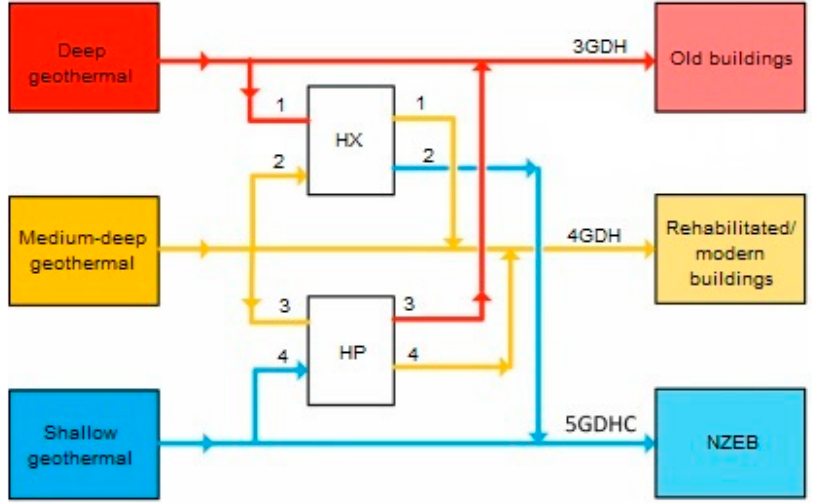
Figure 9. Scheme of the multi-depth geothermal system: 1-1—heat transfer from deep system to 4GDH; 2-2—heat transfer from medium-deep system to 5GDHC; 3-3—heat “upgrade” from medium-deep system to 3GDH; 4-4—heat “upgrade” from shallow system to 4GDH [31].